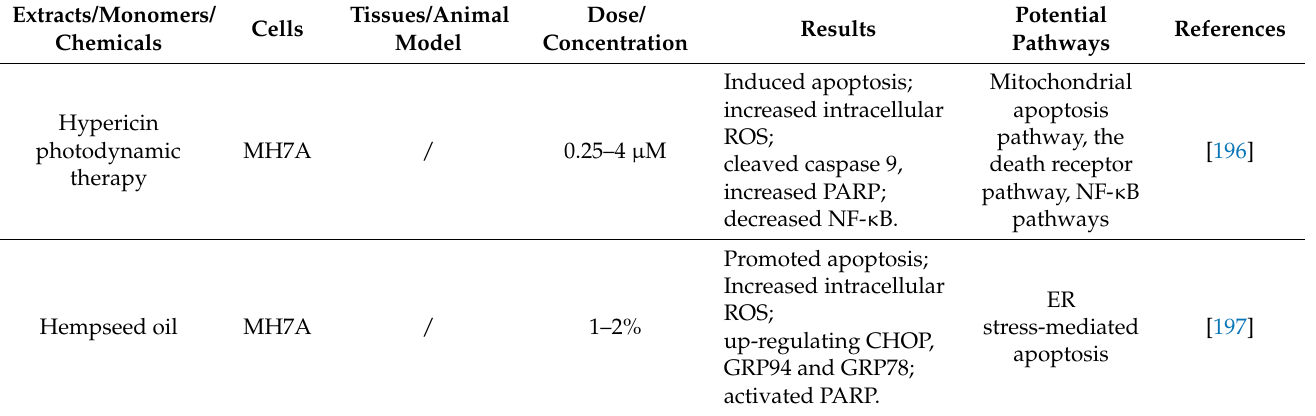
Table 1. Active ingredients and chemical components in traditional Chinese medicine that induce the ROS level in RA-related cells to improve